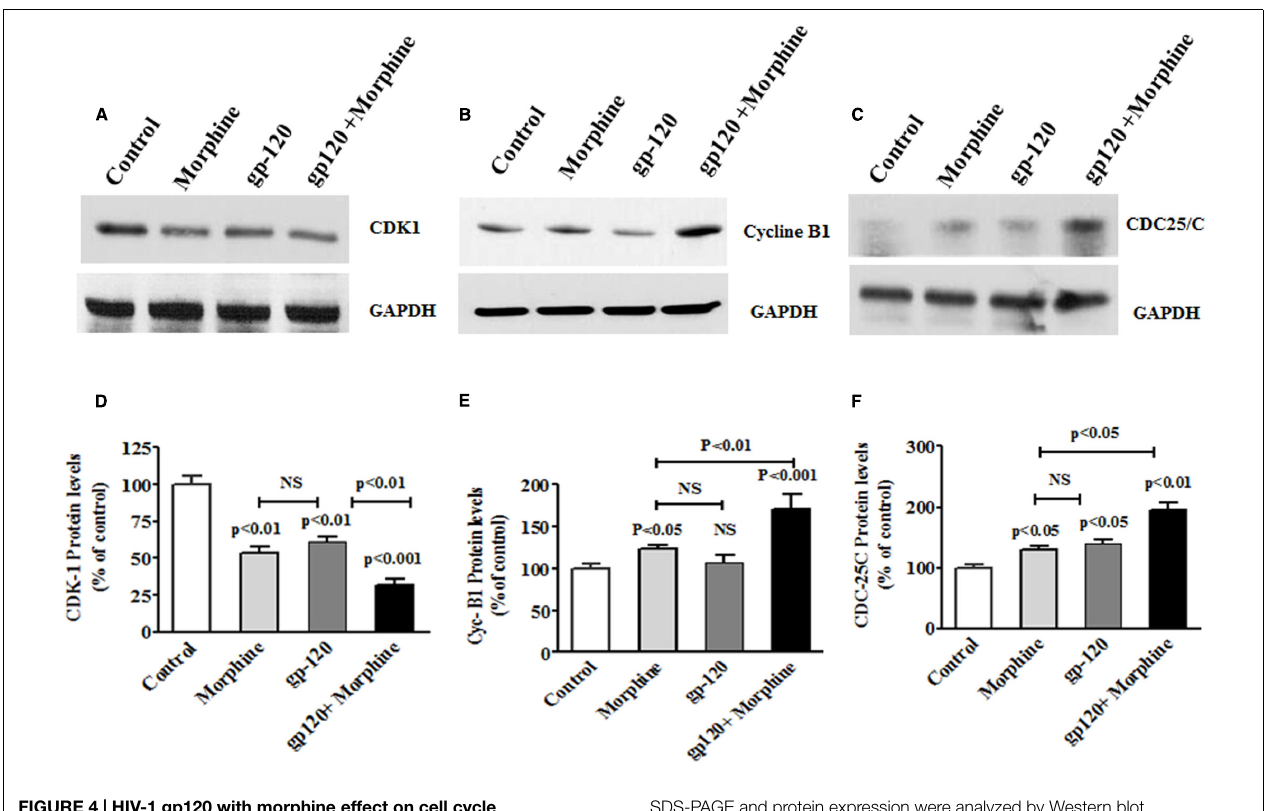
FIGURE 4 | HIV-1 gp120 with morphine effect on cell cycle proteins. Microglia (1 (cid:2) 10 6 cells/ml) were treated with HIV-1 gp120 (100 ng), morphine (0.5 µ M) and combination of HIV-1 gp120 with morphine. Controls were maintained by drug free medium. The end of the incubation, equal amount of protein lysate were resolved by 4–15%